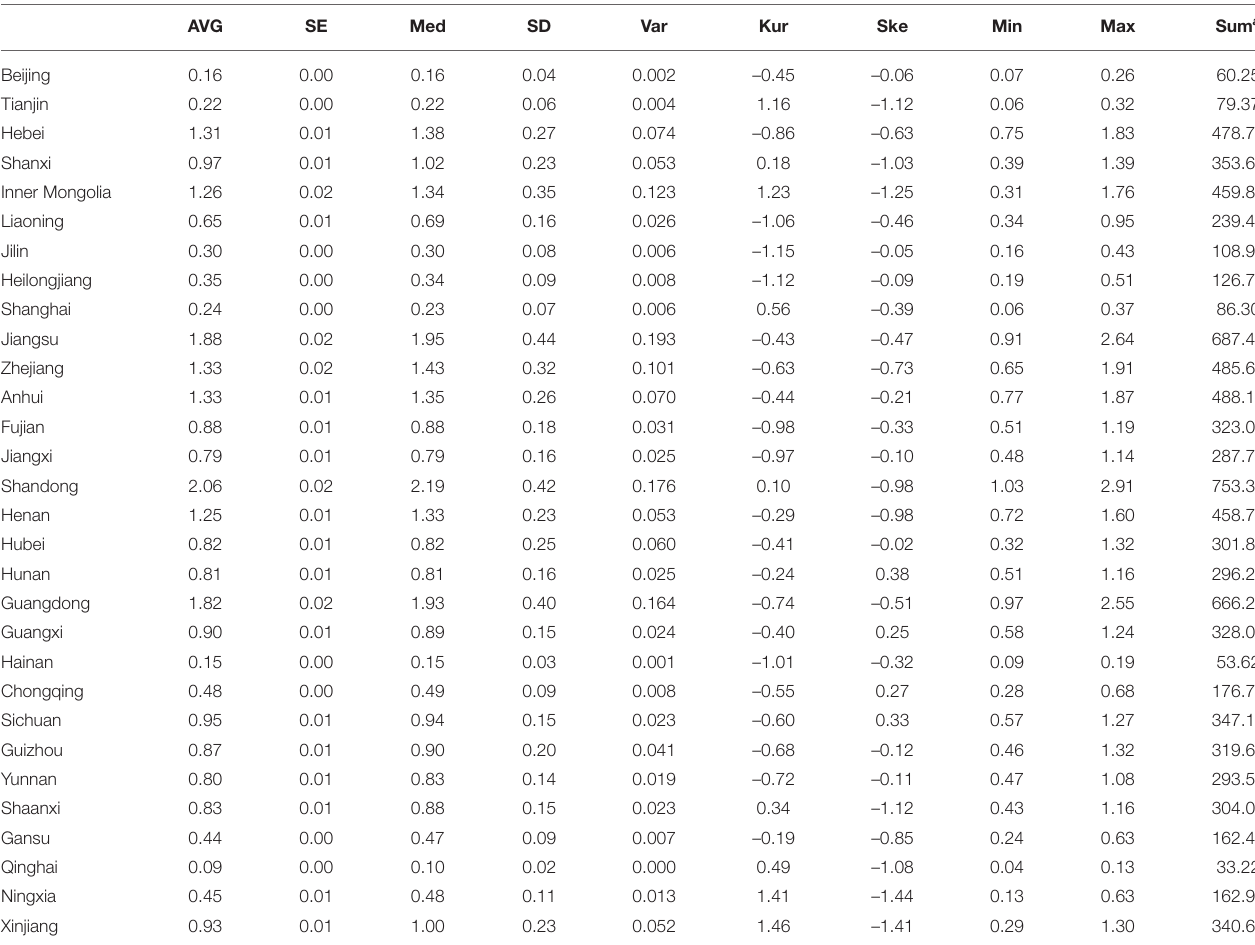
TABLE 1 | Statistical indicators of carbon dioxide emissions of 30 provinces. AVG SE Med SD Var Kur Ske Min Max Sum